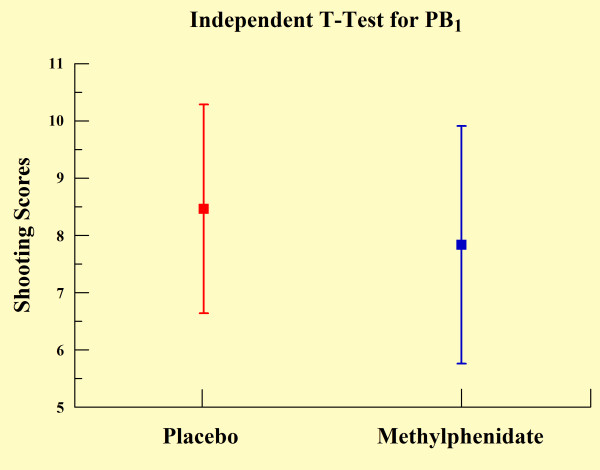
Independent t-test between experimental conditions for the first practice block (p < 0.012).